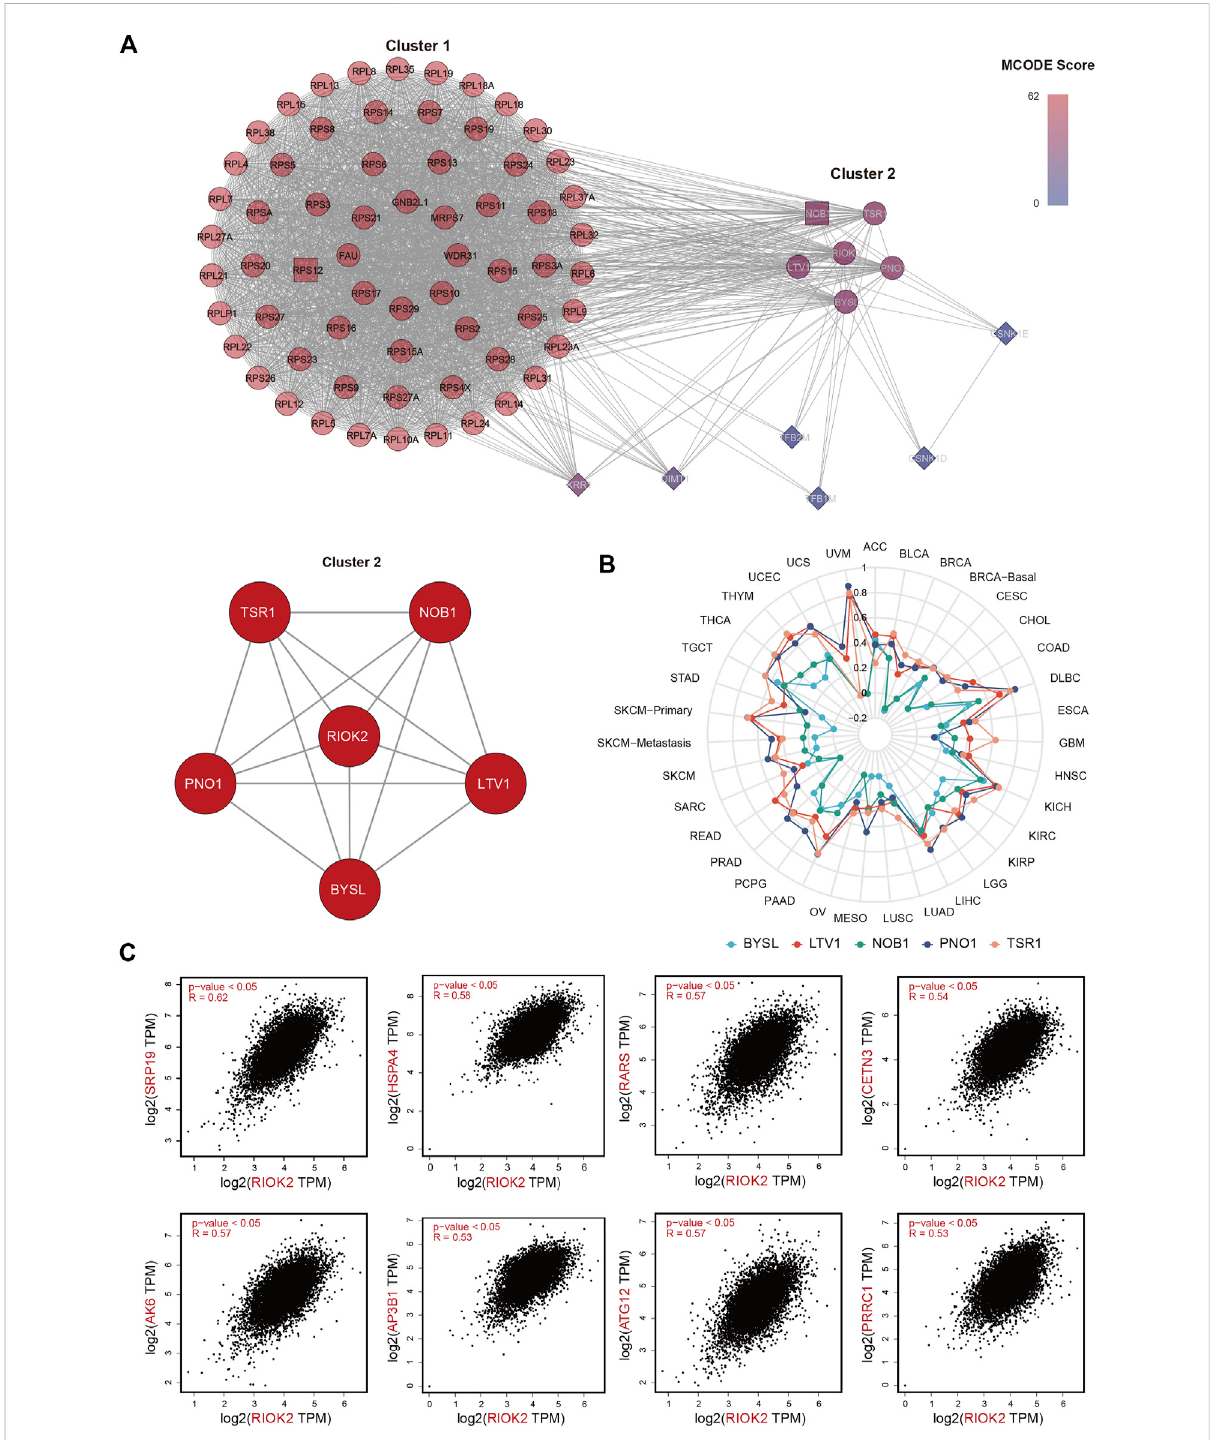
RIOK2-related genes and proteins analysis in tumor tissues. (A) A connectivity map of the PPI network involving 76 experimentally available RIOK2 interaction proteins from the STRING database linked via 2,290 interactions. Major hubs are highlighted in red. The minimum required interaction score was for medium con fi dence (0.400). The resulting PPI network was visualized using Cytoscape and further analyzed using molecular complex detection. (B) A radar chart shows that thecorrelation betweenRIOK2 expressionand fi ve proteins was assessed by purity- adjusted partial Spearman ’ s rho-value in pan-cancer. (C) Genes that correlated with RIOK2 expression with the top 500 Spearman correlation coef fi cients were obtained from TCGA. The expression correlation of the top eight RIOK2-related genes and RIOK2 was visualized by scatter plots using Spearman ’ s correlation for supplementary veri fi